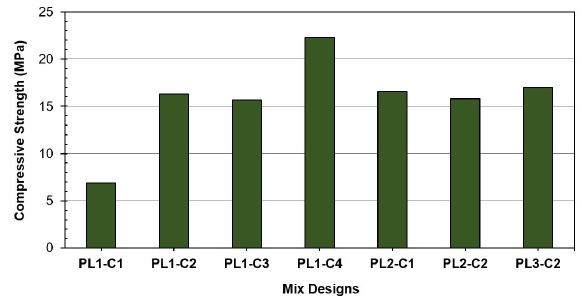
Figure 4: Compressive strength of the bricks according to the plas- tic type used